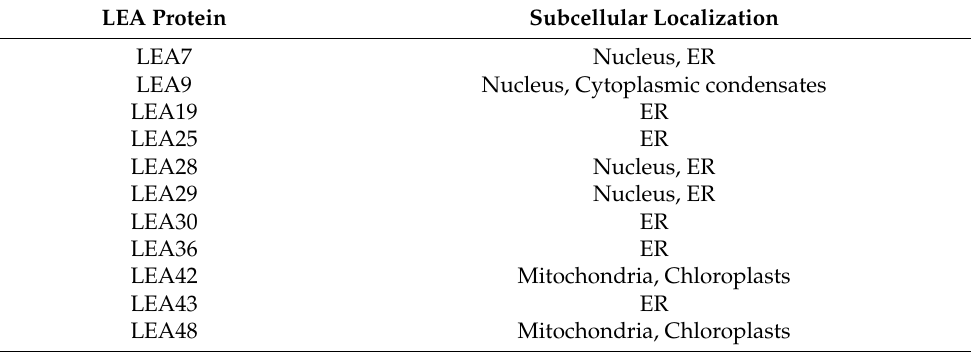
Table 1. Summary of the subcellular localization of seed-expressed LEA_4 proteins in embryos dissected from dry seeds. ER—Endoplasmic Reticulum. For ER-localized proteins, an additional cytoplasmic localization cannot not be ruled out completely. LEA Protein Subcellular Localization LEA7 Nucleus, ER LEA9 Nucleus, Cytoplasmic condensates